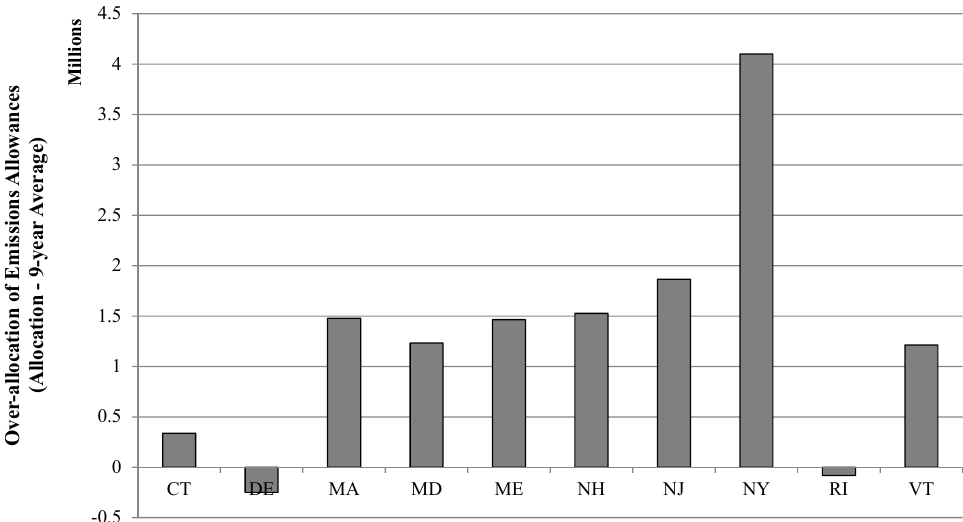
Figure 2. Government over-allocation of emissions allowances in the New England carbon market (Note: Values in Figure 2 are the state by state difference between reported 2000–2008 emissions from RGGI carbon inventory and state final allowance allocations (issued allowances); Over-Allocation = Allowances Issued—Annual Average 2000–2008 Emissions Inventory .).